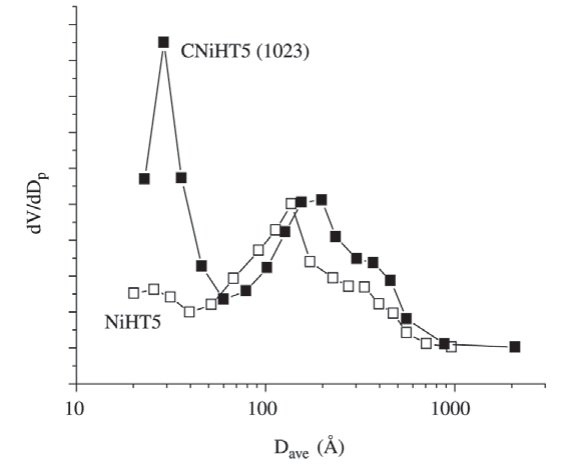
Figure 4. Pore size distribution for NiHT5 and CNiHT5 (1023 K) samples.